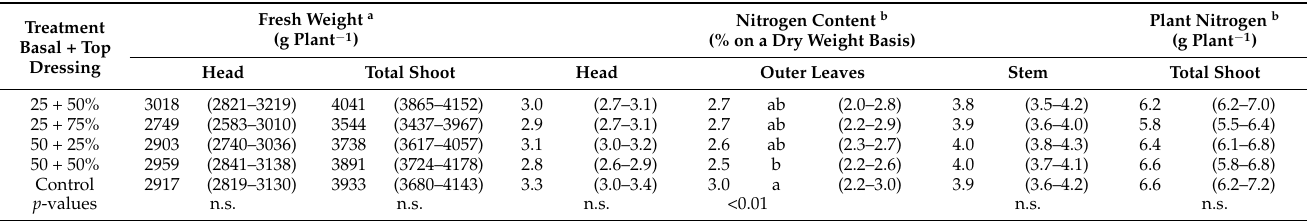
Table 3. Effects of variable fertilization on the yield of cabbage and nitrogen content (Trial 3). Medians followed by the same letter are not significantly different according to the Kruskal–Wallis test. n.s. indicates no significance at p < 0.05.